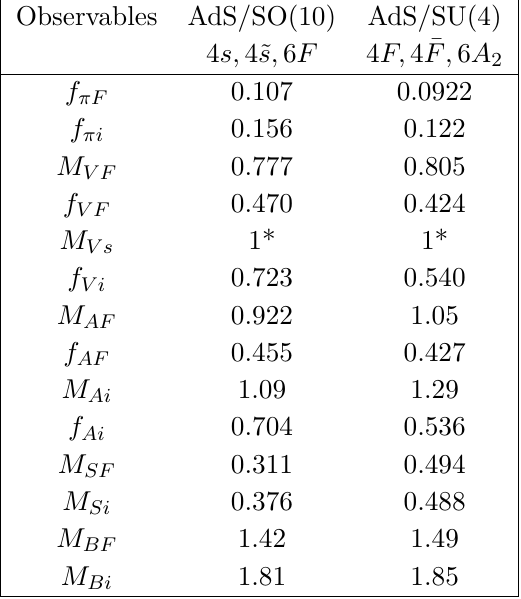
Table 11. Holographic results for masses and decay constants in the SO(10) 4 s, 4˜ s, 6 F and SU(4) 4 F, 4 ¯ F, 6 A 2 models. i = s for the former and i = A 2 for the latter.